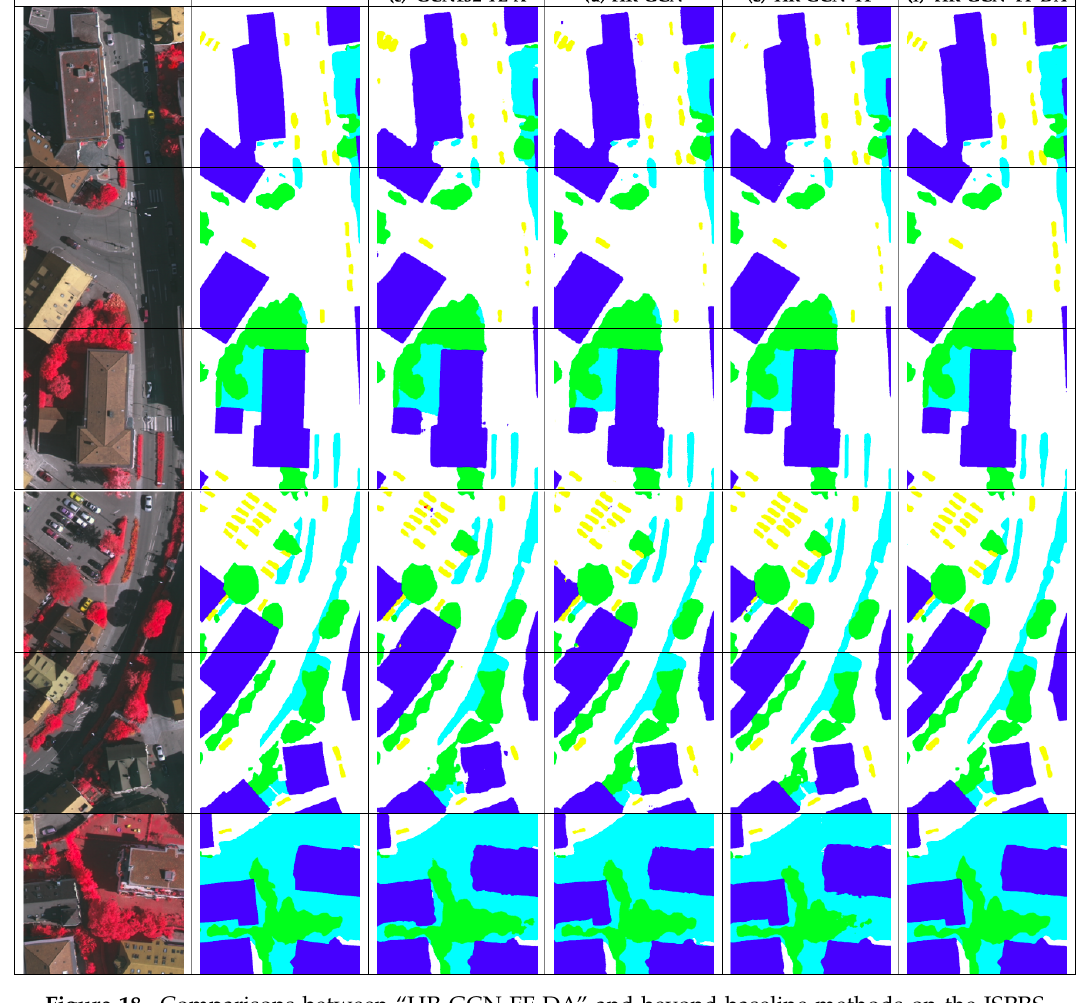
Figure 18. Comparisons between “HR-GCN-FF-DA” and beyond baseline methods on the ISPRS Vaihingen (Stuttgart) challenge corpus testing